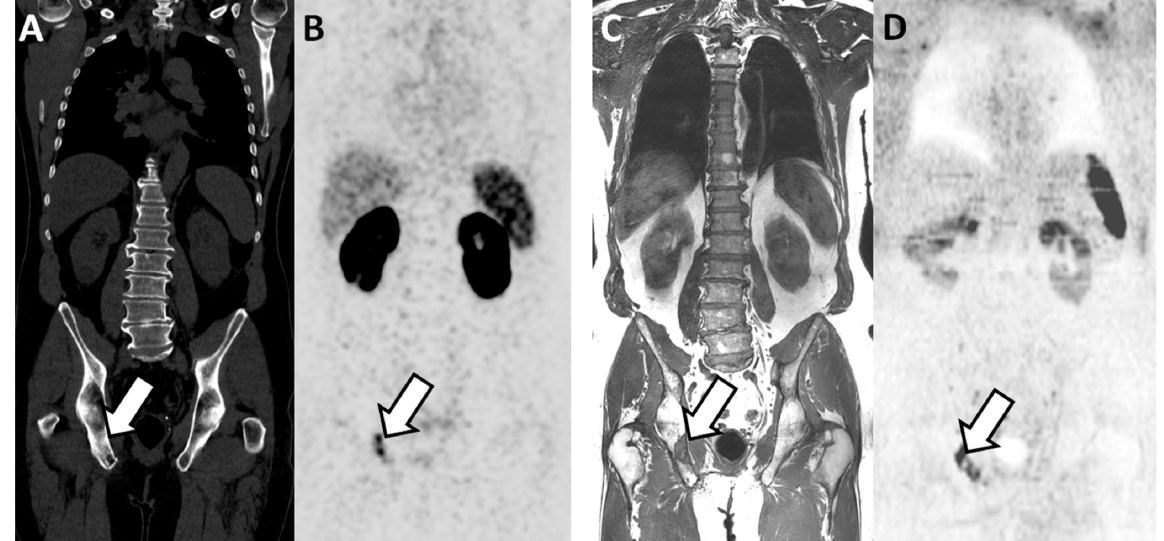
Figure 2. Concordant findings between PSMA PET/CT and WB-MRI/DWI: true positive observation of bone metastasis by WB-MRI/DWI in 65-year-old patient with ND prostate cancer at high risk for metastasis. ( A , B ) PSMA PET/CT: reformatted coronal CT ( A ) and PET ( B ) images show sclerotic lesion within the right ilio-ischiatic ramus with evident tracer uptake (arrows in ( A , B )). ( C , D ) WB-MRI/DWI images: corresponding reformatted high resolution T1 ( C ) and diffusion-weighted ( D ) MRI images show bone lesion of low signal intensity on T1 and high signal intensity on MR images (inverted grey scale in the figure) within the right ilio-ischiatic ramus. The best valuable comparator confirmed the metastatic nature of the lesion.